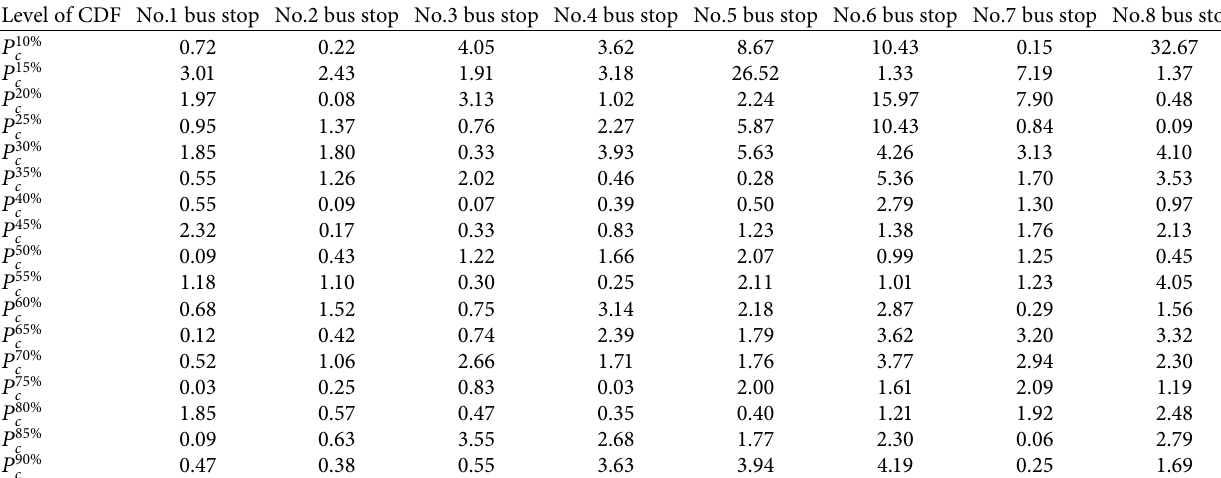
Table 7: Relative error between actual and fitted FR for test bus stops at different CDF